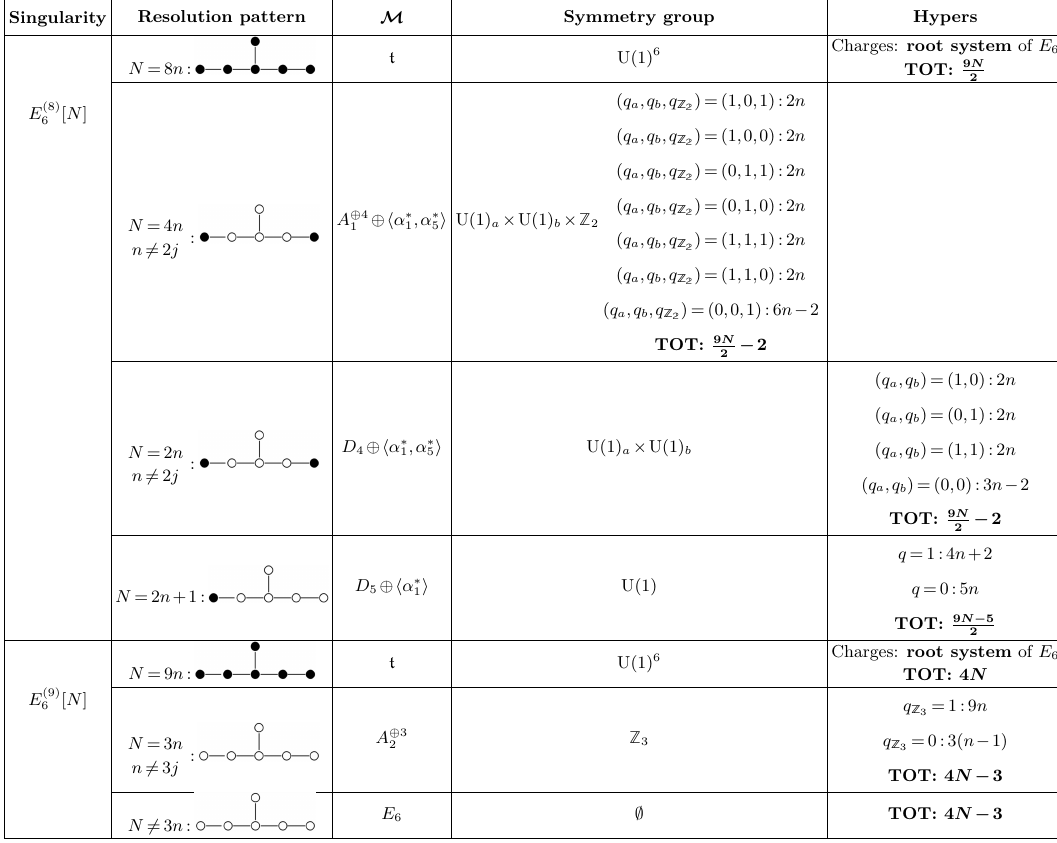
Table 6 . Higgs branch data for quasi-homogeneous cDV singularities of E (8)